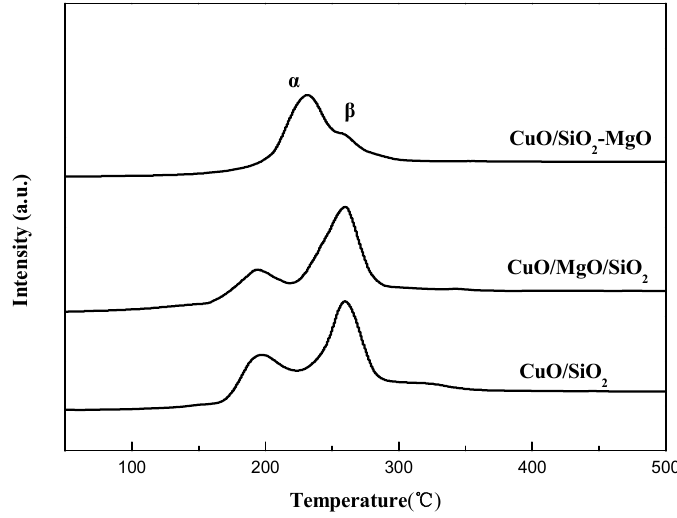
Figure 12. H 2 -TPR profiles of the catalysts.